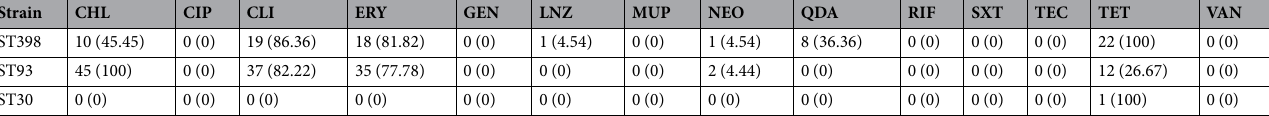
Table 1. Number and proportion of each methicillin-resistant Staphylococcus aureus strain resistant to non- β - lactam antimicrobials. CHL (chloramphenicol), CIP (ciprofloxacin), CLI (clindamycin), ERY (erythromycin), GEN (gentamicin), LNZ (linezolid), MUP (mupirocin), NEO (neomycin), QDA (quinupristin-dalfopristin), RIF (rifampin), SXT (trimethoprim/sulfamethoxazole), TEC (teicoplanin), TET (tetracycline), VAN